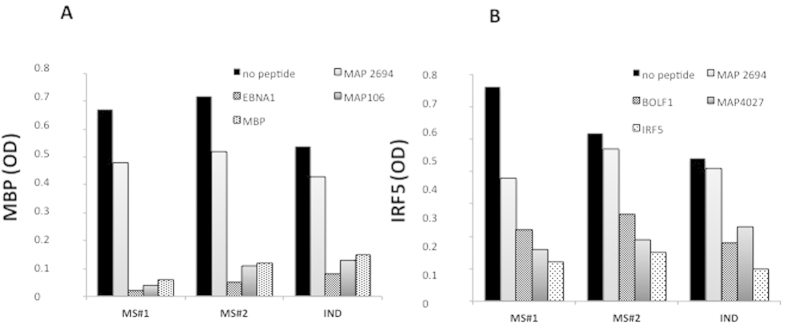
Competition assay with MBP (A) and IRF5 (B) coated ELISA plates. (A) CSF from 2 MS patients and 1 IND were pre-incubated overnight with saturating concentrations [10 μM] of MAP269438–46 (negative control), EBNA1400–413, MAP 106121–132 and MBP 85–98 (positive control), The first bar represents a regularly performed ELISA (1:2 CSF in PBS-T) peptide. (B) The same CSF were pre-incubated with MAP269438–46 (negative control), BOLF1305–320, MAP_402718–32, and IRF5424–434 (positive control). The first bar represents a regularly performed ELISA (1:2 CSF in PBS-T) peptide.